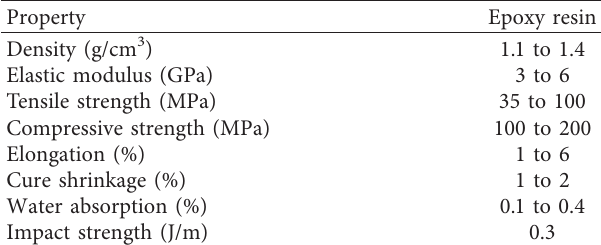
Table 1: Properties of epoxy resin (LY556)